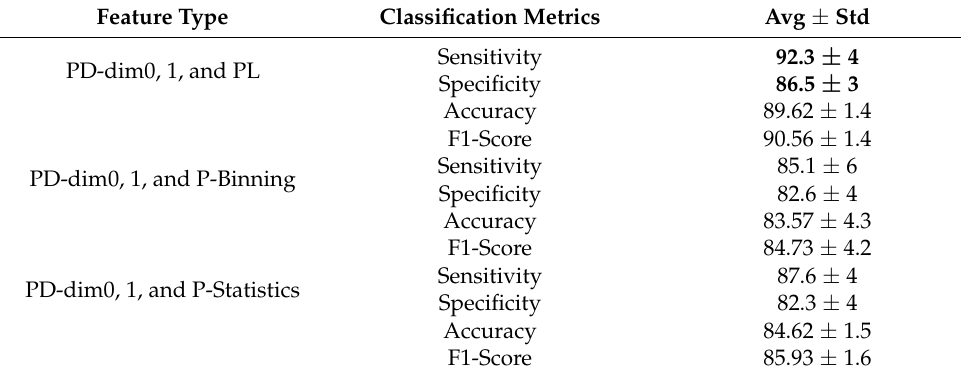
Table 3. Concatenation of all ULBP geometries together with dimension 0 and 1 of the PD for DDSM classification using the top three PD vectorization.